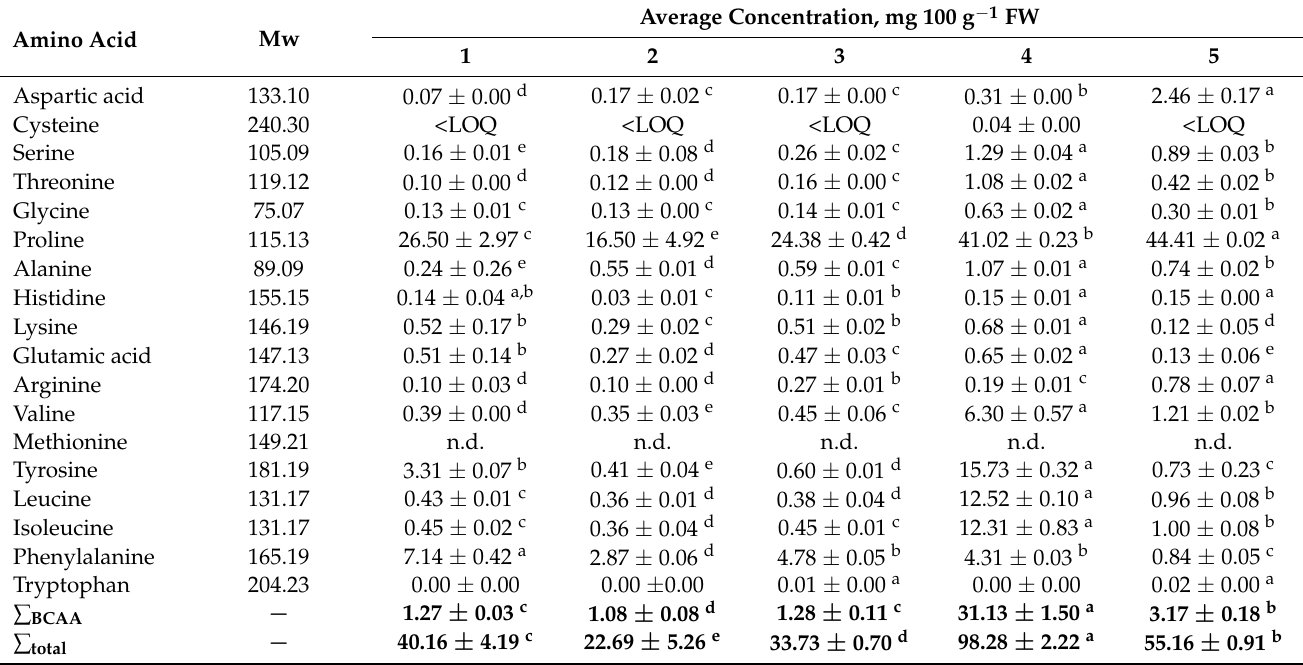
Table 3. The concentration of free amino acids in selected honey